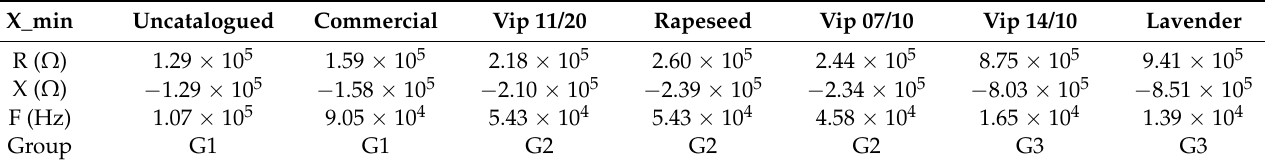
Table 4. Characteristic values at minimum reactance (more negative).